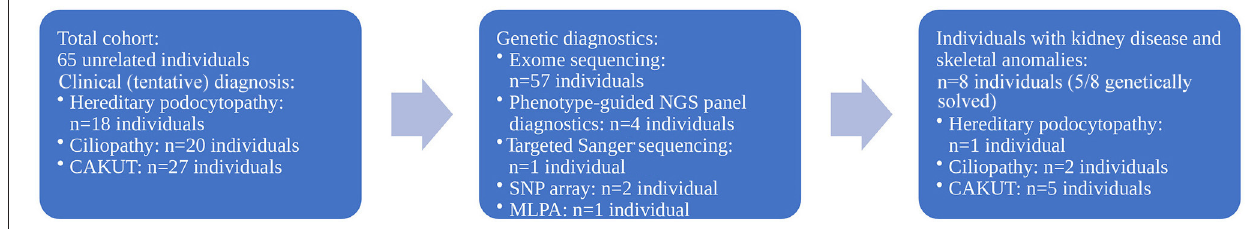
FIGURE 2 | Flowchart of the cohort. CAKUT, congenital anomalies of the kidney and urinary tract; MLPA, multiplex ligation-dependent probe amplification; NGS, next-generation sequencing; SNP, single nucleotide polymorphism.